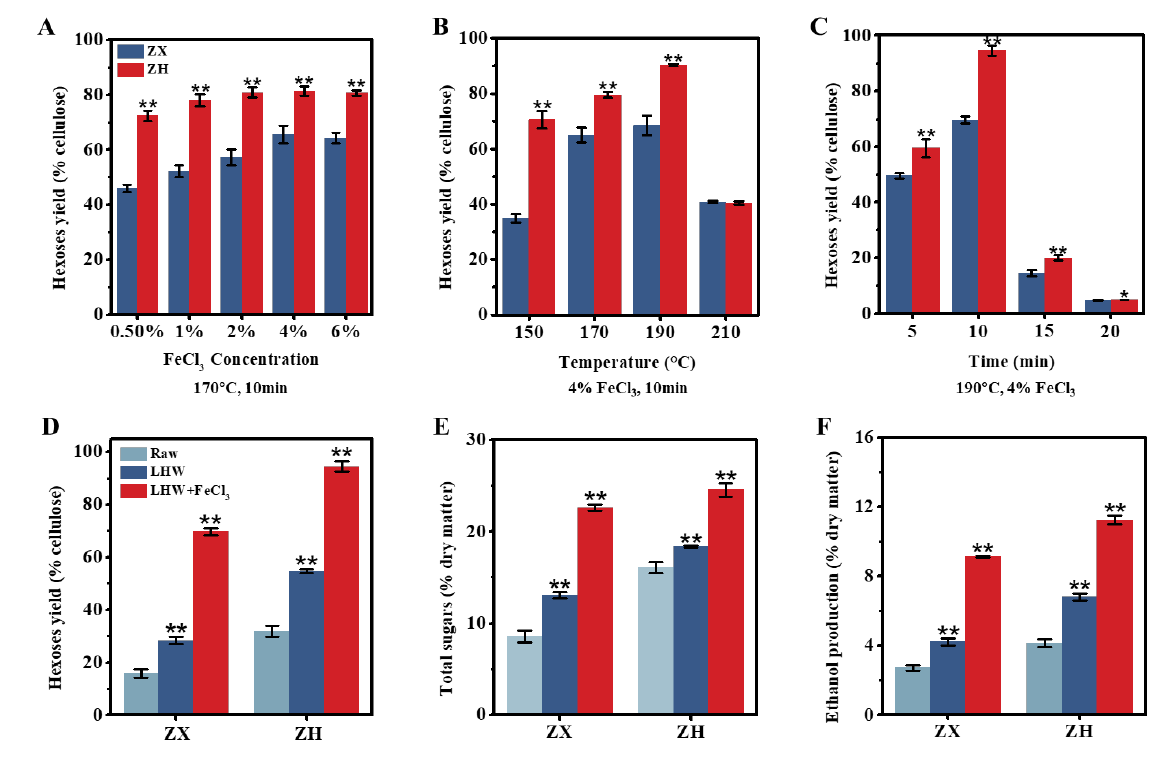
Figure 1. Optimal liquid hot water (LHW) pretreatment co-supplied with FeCl 3 for biomass enzy- matic saccharification and bioethanol production in two corn (ZX, ZH) cultivars. ( A – C ) The LHW drolyses of pretreated residues; ( D , E ) hexose and total sugar yields under two pretreatments